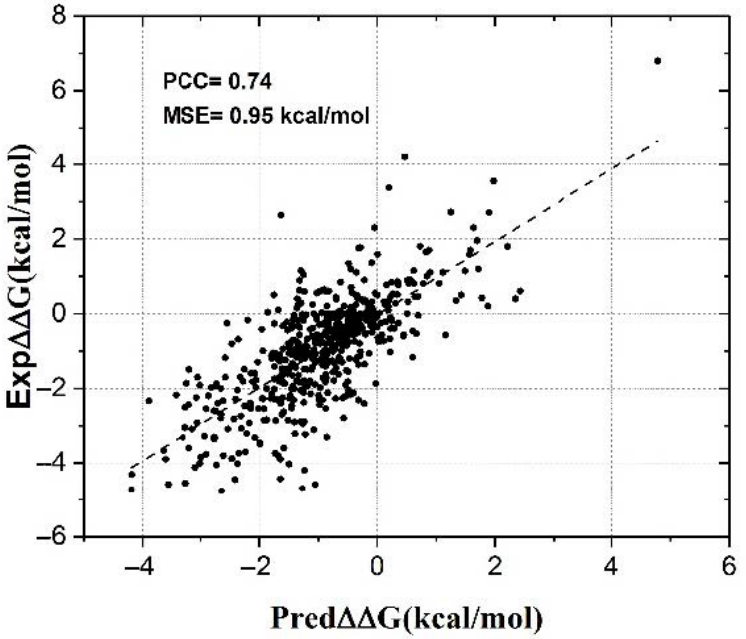
Figure 1. SAAFEC-SEQ predicted ∆∆ G against experimental ∆∆ G in case of 20% of mutations as a test set.